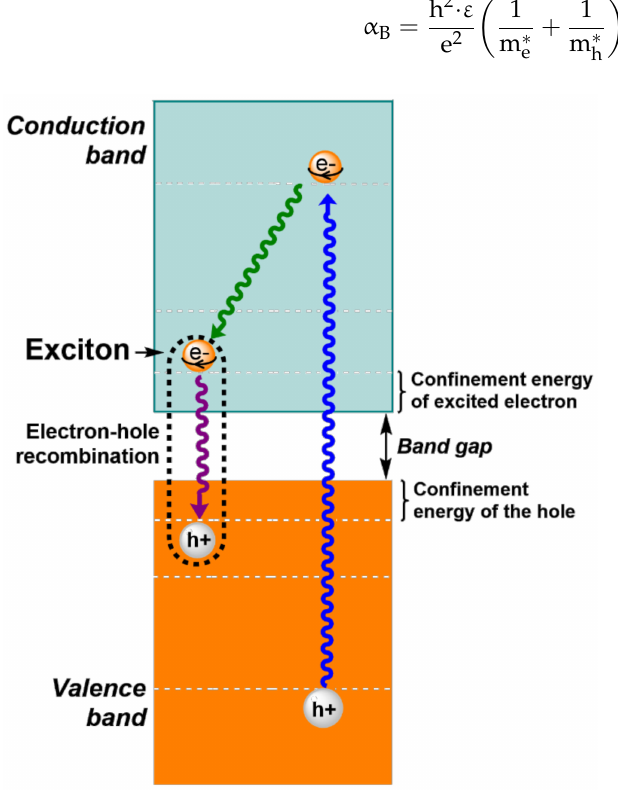
Figure 1. Formation of the exciton from the electron-hole pair and subsequent electron-hole